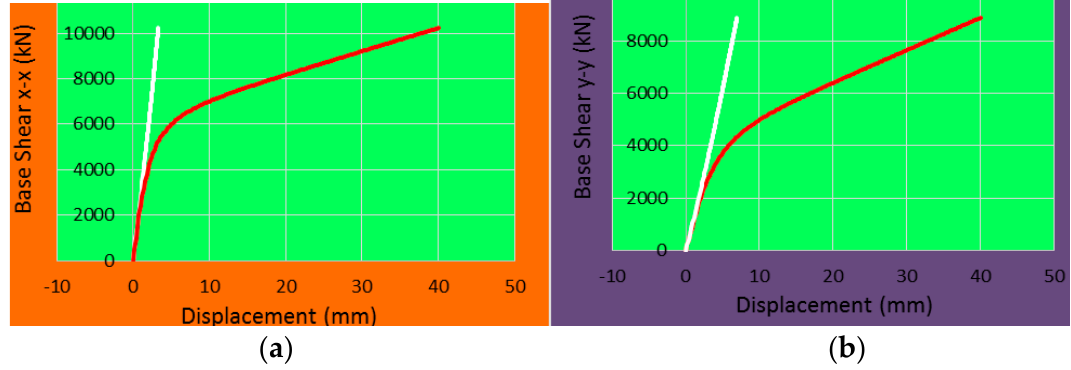
Figure 21. ( a ) Push-over in the East-West direction (Ey)—detachment of the West wall; ( b ) Push-over in the North-South direction (Ex)—detachment of the North wall.